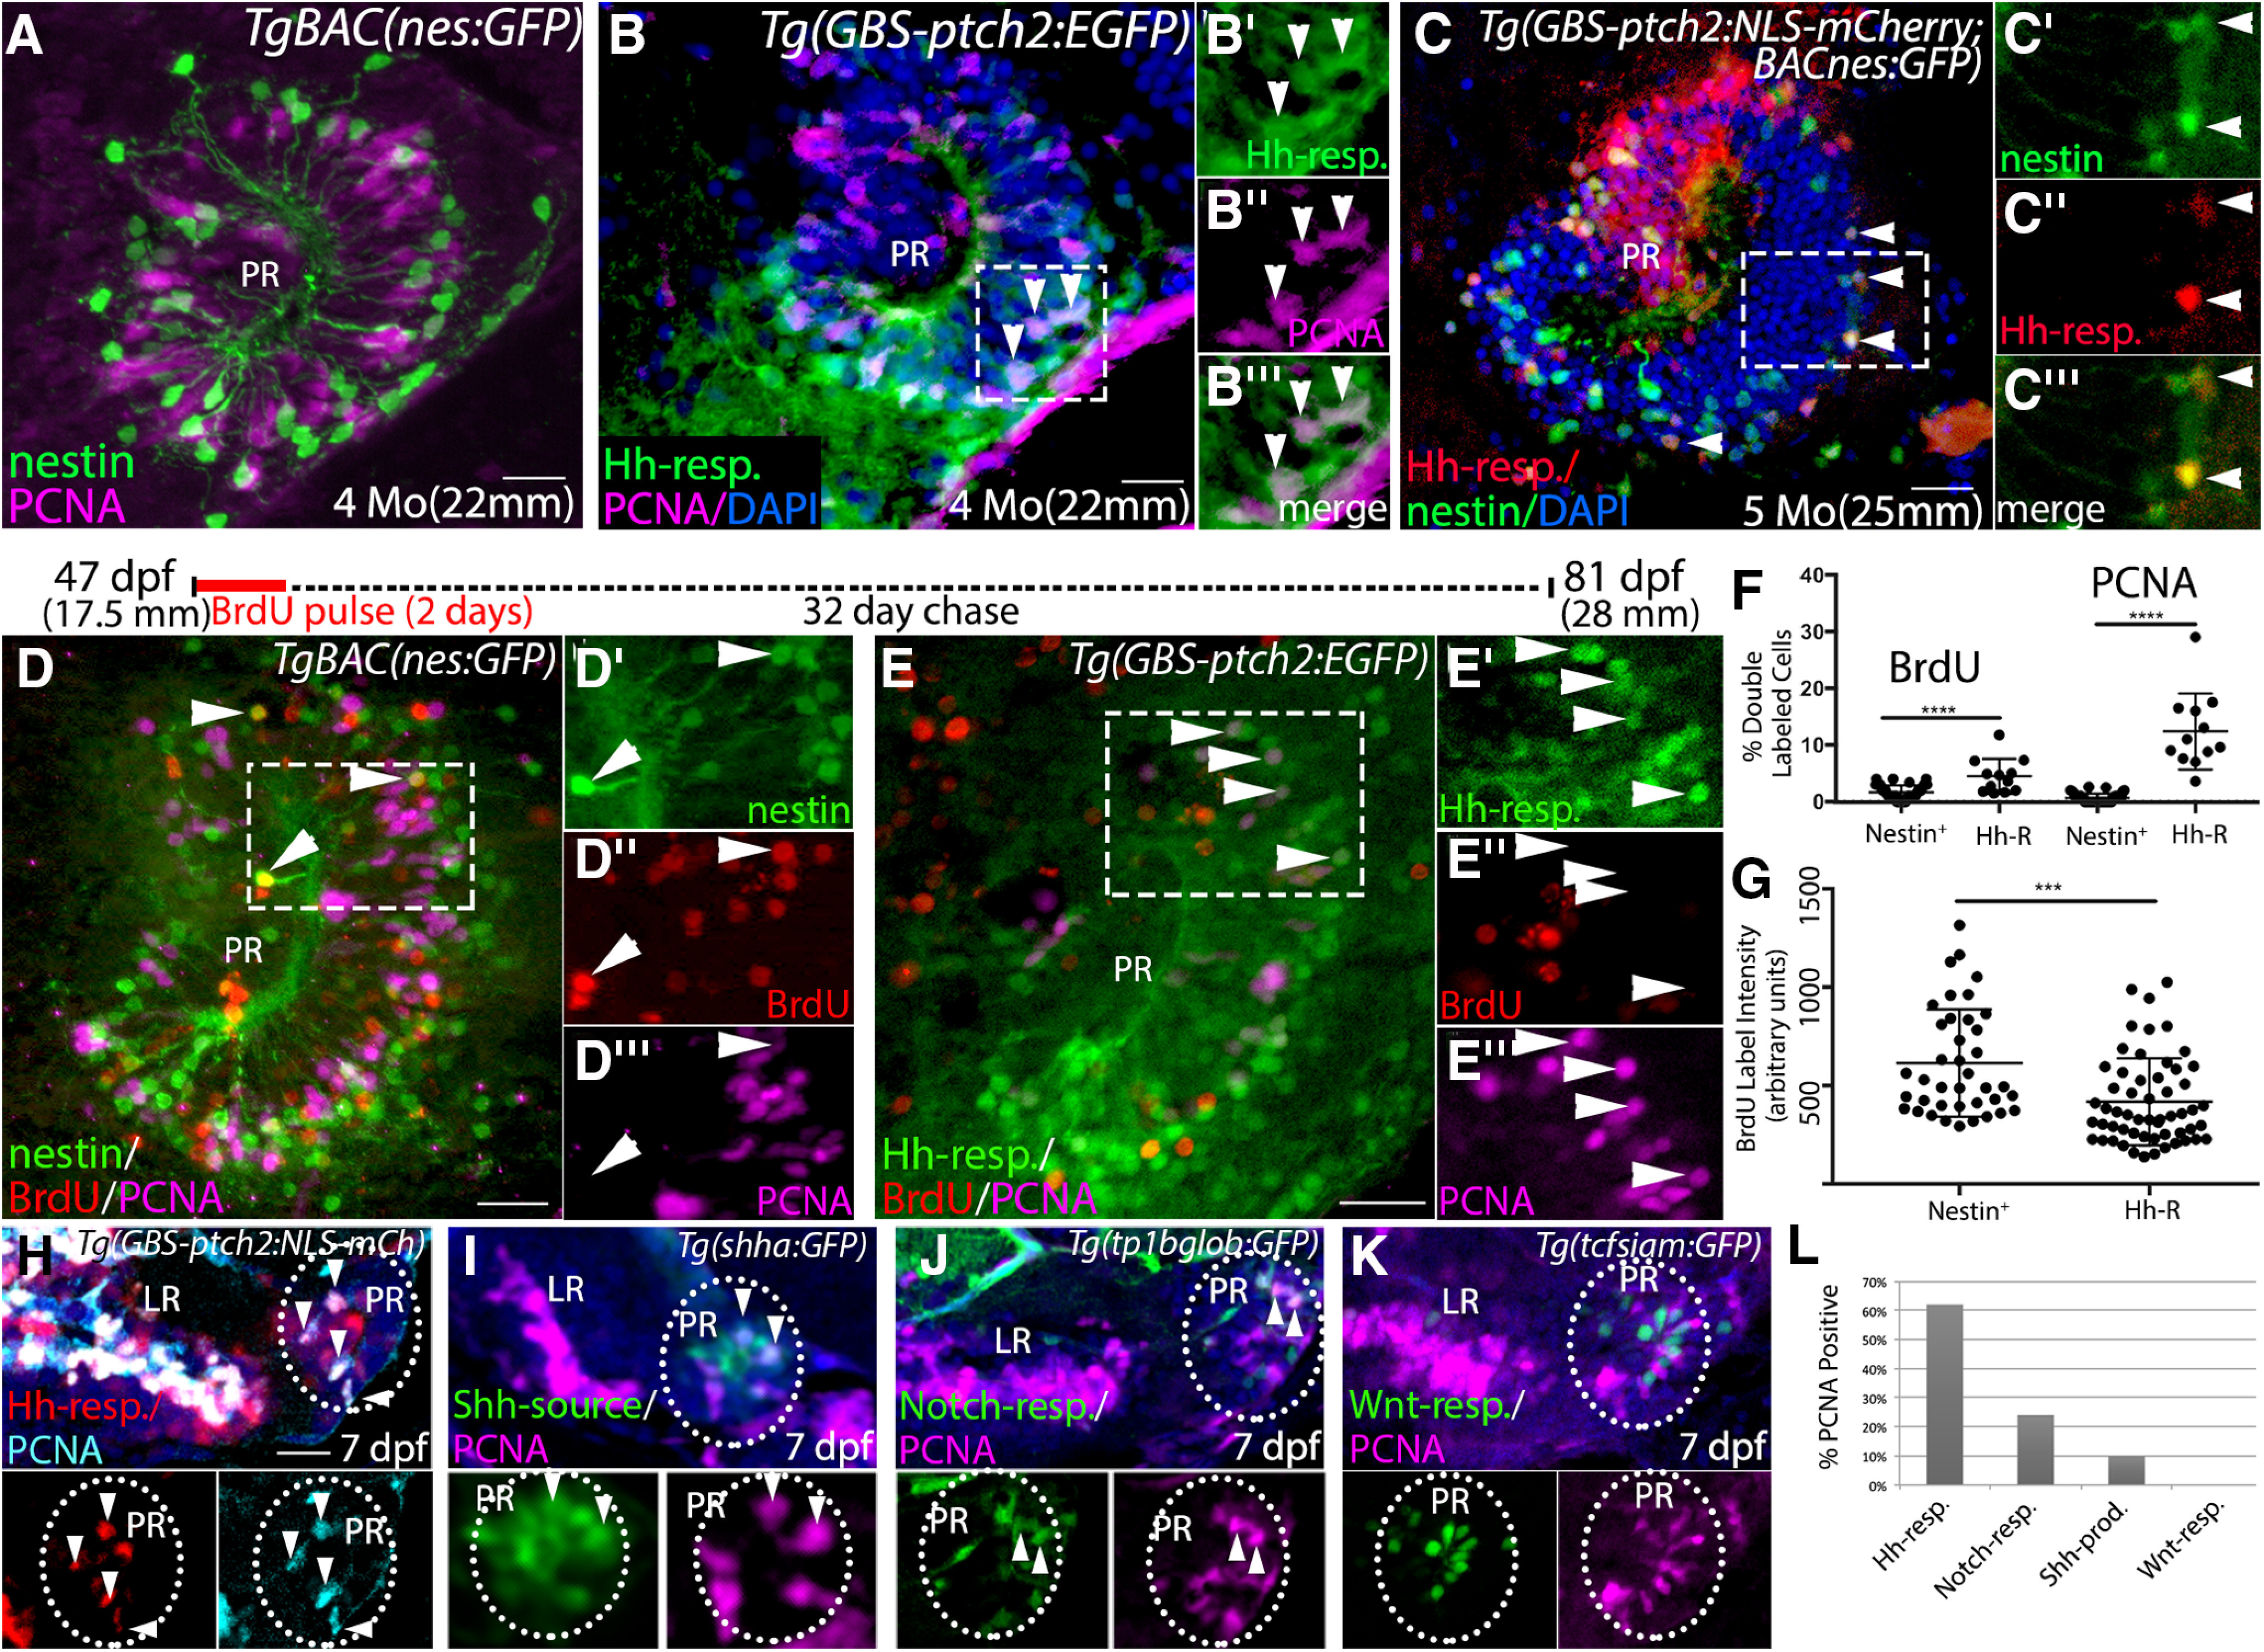
Hh-responsive cells are more highly proliferative than other radial glia in the hypothalamus. A, Sagittal tissue section through the PR of a TgBAC(nes:EGFP) transgenic adult brain showing PCNA antibody-labeled proliferative cells. Nestin-expressing cells are predominantly PCNA negative. B, Sagittal tissue section through the PR of a Tg(ptch2:EGFP) transgenic adult brain showing PCNA antibody labeled proliferative cells. Arrowheads indicate examples of PCNA-labeled (proliferative) Hh-responsive cells. Panels at right show separated channels from the boxed region. C, Hh-responsive cells (red) are largely distinct from Nestin-expressing cells (green) in the PR of the adult hypothalamus, as visualized in Tg(GBS-ptch2:NLS-mCherry;nes:EGFP) double transgenic fish. However, 17% of cells (74 cells of 442 total) contained both GFP and mCherry (arrowheads, n = 9 tissue sections from 3 double transgenic fish) with GFP fluorescence substantially lower in double-labeled cells. Panels at right show separated channels from the boxed region. D, E, BrdU pulse-chase experiment. Schematic above panels shows timing of pulse and chase, with 47-dpf adult TgBAC(nes:EGFP) or Tg(GBS-ptch2:EGFP) fish being exposed to 10 μm BrdU in fish water for 2 d; 32 d later fish were killed, and tissue sections were labeled using anti-BrdU (red) and anti-PCNA (magenta) antibodies. D, Representative sagittal section through the PR of a TgBAC(nes:EGFP) adult, insets show single channel data for the boxed region. A small number of Nestin-expressing cells in the PR retained the BrdU label after one month. These cells did not express PCNA (arrowheads), indicating they were not in G1/S/G2 of the cell cycle at the time of fixation. E, Representative sagittal section through the PR of a Tg(GBS-ptch2:EGFP) adult, insets show single channel data for the boxed region. Most Hh-responsive cells failed to retain the BrdU label after one month, and many of these cells expressed PCNA (arrowheads), indicating active cell cycling at the time of fixation. F, Graph showing the percentage of Nestin-expressing or Hh-responsive cells that co-labeled with the BrdU or PCNA antibodies. Tg(nesGFP): n = 3 fish, 13–16 tissue sections per fish. Tg(GBS-ptch2:EGFP): n = 2 fish, 13–16 sections per fish. G, Quantification of BrdU label intensity in Nestin-expressing and Hh-responsive cells showing BrdU labeling intensity was significantly lower in Hh-responsive cells compared with nestin-expressing cells. H–K, Representative images of PCNA labeling in single confocal optical sections from sagittal sections through the hypothalamus in 7-dpf larvae expressing four different transgenes. Top panels show merged images (transgene reporter + PCNA + DAPI) and bottom panels show single channels. H, In Tg(GBS-ptch2:NLS-mCh) larvae over 60% of NLS-mCherry-expressing cells in the hypothalamic ventricular regions are labeled with the PCNA antibody (arrowheads). In the LR, 214 of 288 NLS-mCherry+ cells labeled with PCNA (74%), while in the PR 110 of 117 (62%) cells were double labeled (n = 12 sections from 3 larvae). I, Shh producing cells were predominantly found in the PR (dotted oval); 19 of 186 GFP+ cells expressed PCNA (10%, arrowheads; n = 15 sections from 3 larvae). J, Notch responsive cells, as revealed in the Tg(Tp1bglob:GFP) line, were also localized to the PR (oval); 27 of 113 GFP+ cells were PCNA+ (24%, arrowheads; n = 11 sections from 3 larvae). K, Wnt-responsive cells are confined to the PR (oval). None of the 266 cells examined expressed PCNA (n = 18 sections from 3 larvae). L, Graph showing the percentage of each transgene-expressing cell type found to also express PCNA; ***p < 0.001, ****p < 0.0001. Source data for graphs can be found in Extended Data Figure 7-1. All panels show 0.5-μm single optical sections of 20-μm tissue sections. Scale bars: 20 μm.